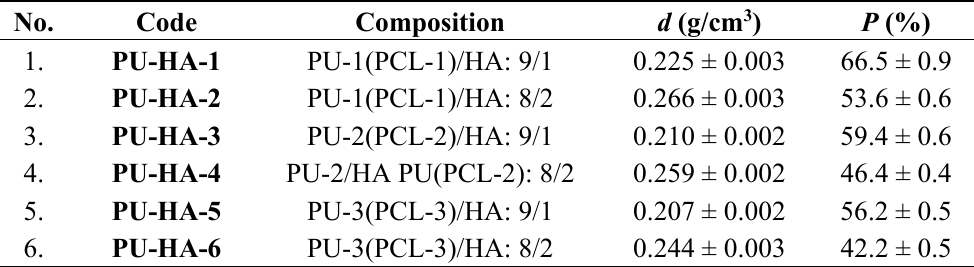
Table 2. Characterization of polyurethane/hydroxyapatite composites.